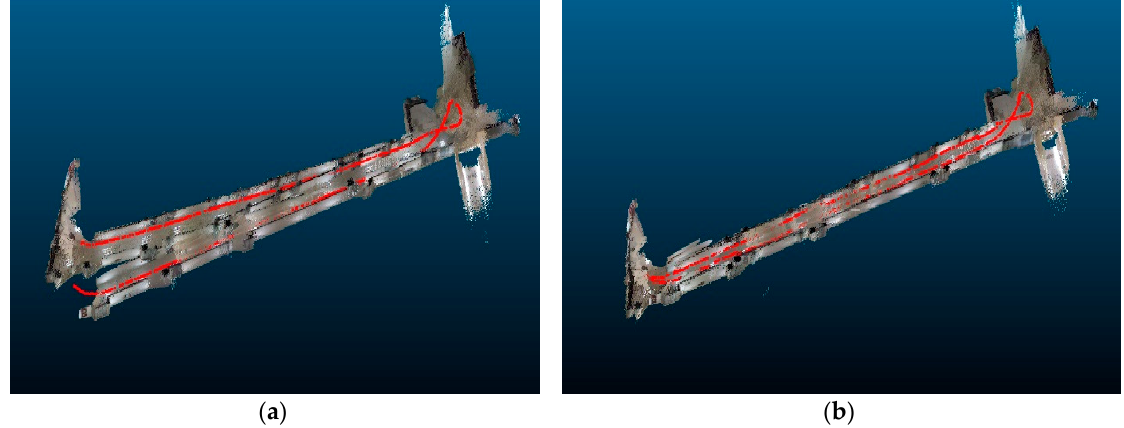
Figure 13. Camera trajectory of the two methods in loop closure experiment. ( a ) Camera trajectory of ORB-SLAM2 and ( b ) camera trajectory of the proposed method. Table 4. Statistical results of matching error between the models generated by the two methods in loop closure experiment and the ground truth LiDAR data.